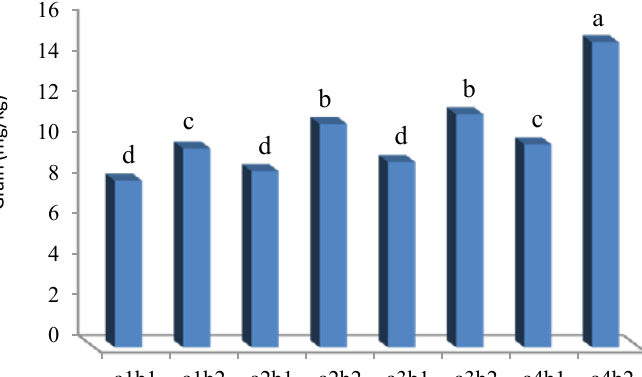
: non-contaminated and b 1